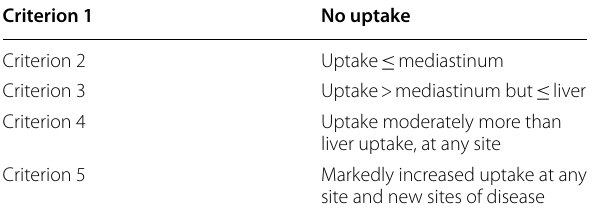
Table 1 The 5‑point scoring system (Deauville score) Criterion